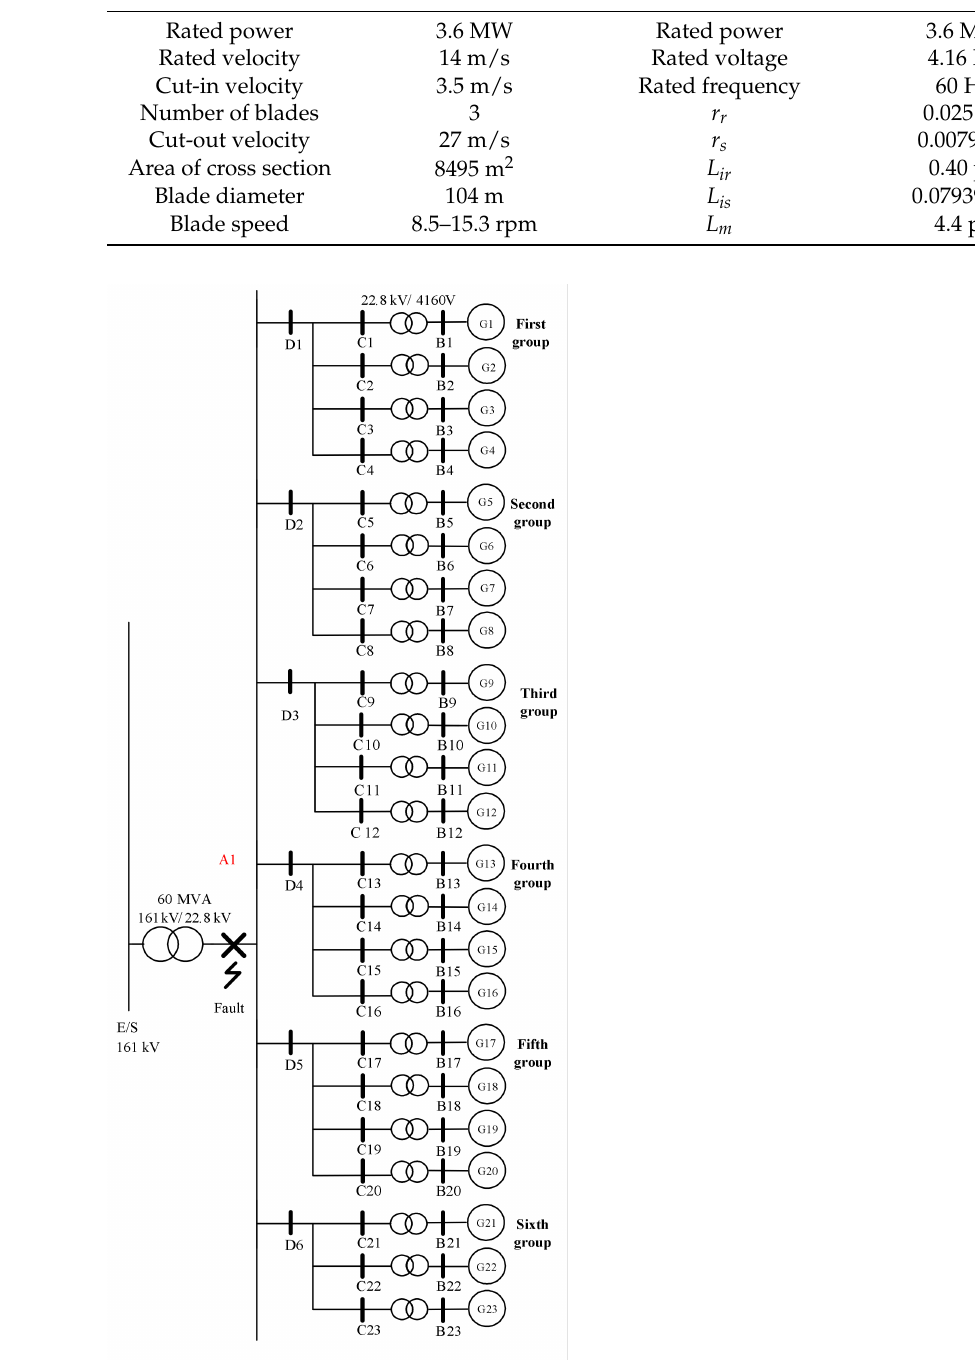
Figure 6. Power system configuration of the wind power generation station at Changhua Coastal Industrial Park,